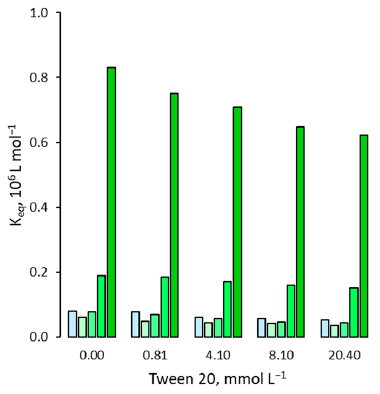
Figure 1. Binding affinity of 2,4,5-T for the MIP in presence of increasing amounts of Tween 20. For each group of bars from left to right: water molar fraction from 0 (pure acetonitrile) to 0.24, 0.42, 0.66 and 0.81.